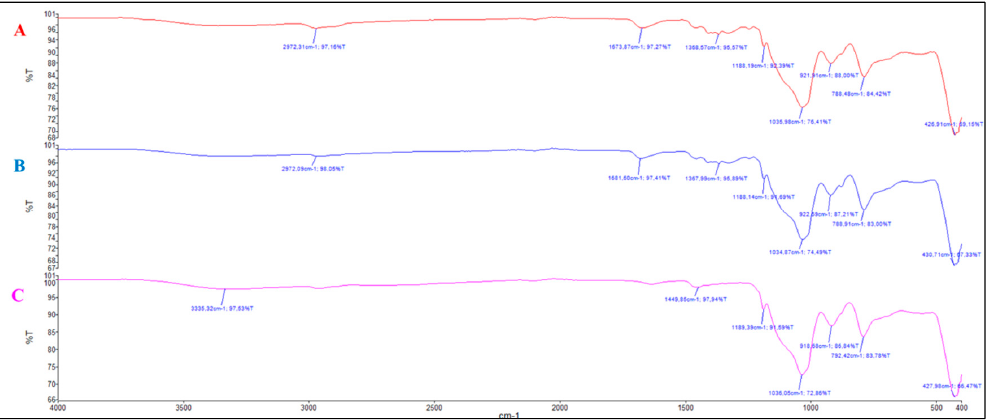
Figure 11. FTIR of E-P3 75 / 25 ( A ) before treatment, ( B ) after heating in distilled water, ( C ) after heating in water at pH = 1.